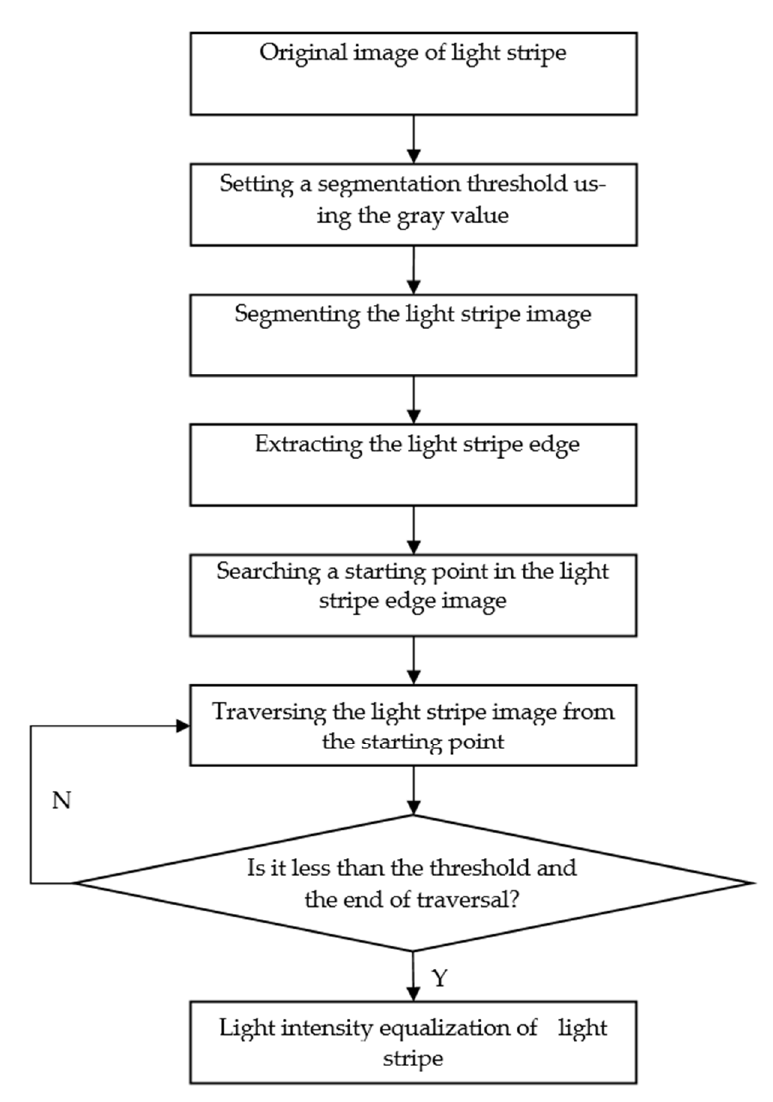
Figure 3. Flow chart of light intensity equalization of light stripe.